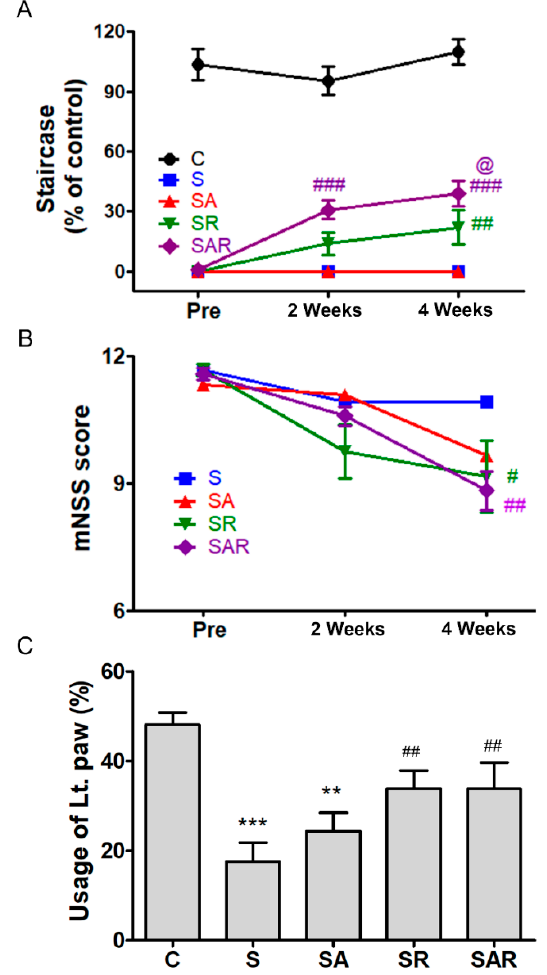
Figure 5. Recovery of motor function on treatment with TST and 5-Azd-dC after a photothrombotic chronic stroke. TST and TST combined with 5-Aza-dC treatment helped improve recovery of motor function after stroke; the staircase test ( A ) and mNSS ( B ), usage scores of damaged limb ( C ). TST combined with 5-Aza-dC enhanced motor recovery in the treated group, as shown in the staircase test performance ( A ). Pre-indicated 1 day before rehabilitation after a stroke. ** p < 0.01; *** p < 0.001 vs. C (sham control), # p < 0.05; ## p < 0.01, ### p < 0.001 vs. S (Stroke). @ p < 0.05 vs. SR (TST treated stroke). Results are presented as the mean ± SEM, n = 12/group. Lt. paw: impaired left paw.